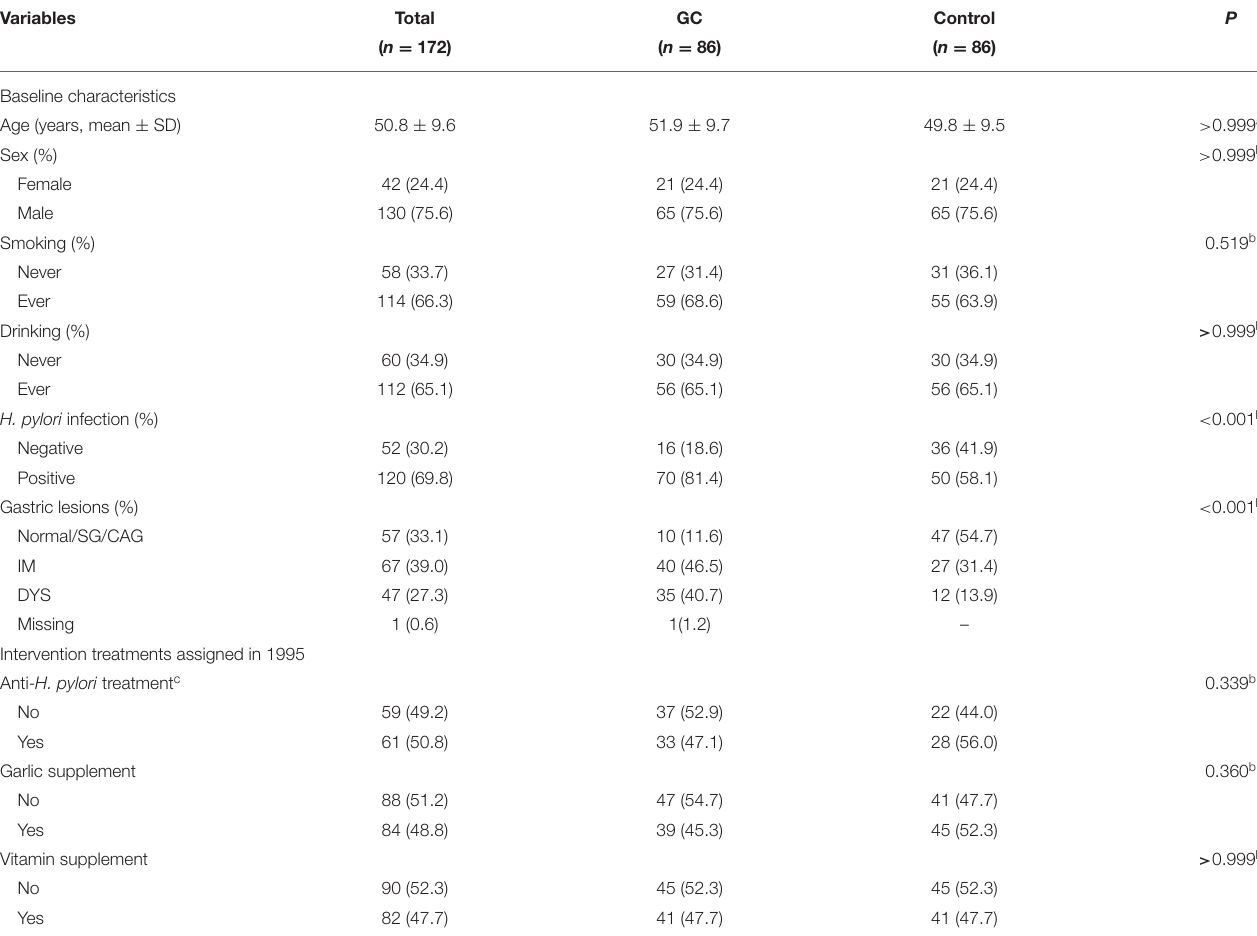
TABLE 1 | Selected characteristics of subjects in GC and control groups.